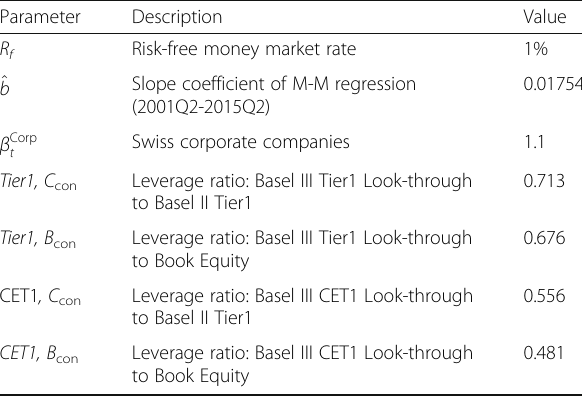
leverage ratios Tables 14 and 15 list the parameters and the values used in the calculation of the optimal leverage ratio for Basel III Tier1 and CET1 capital.